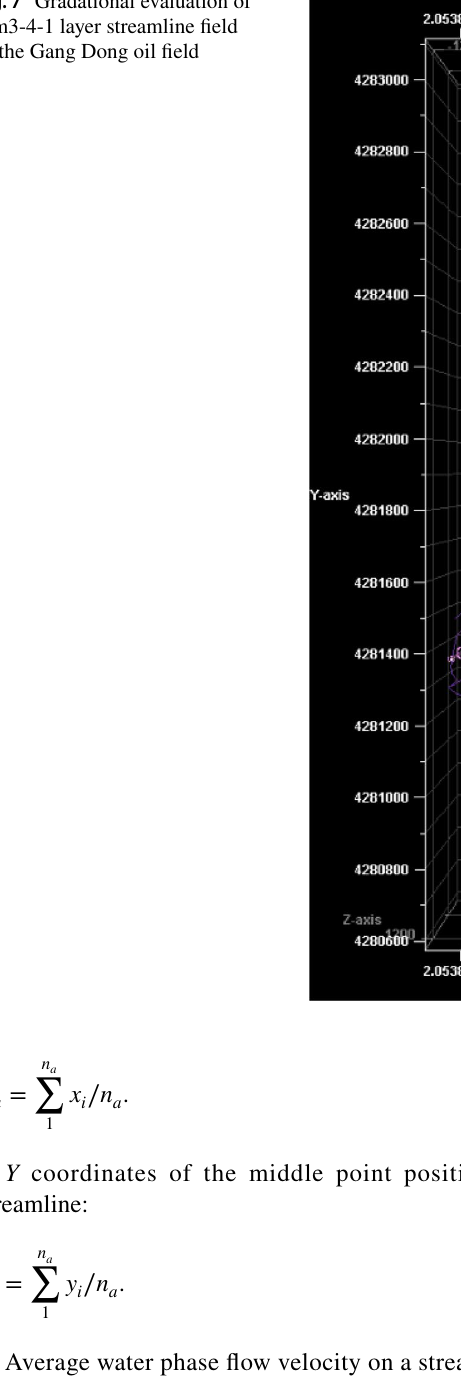
Fig. 7 Gradational evaluation